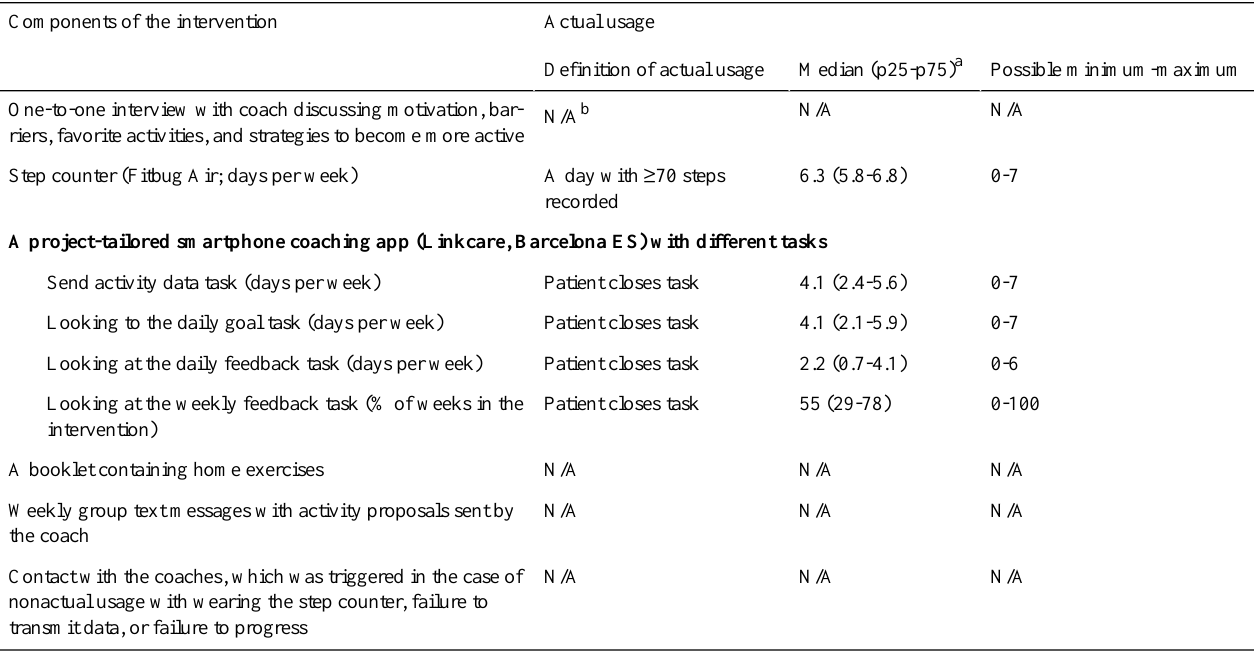
Table 2. Overview of the different components of the intervention. Definition of actual usage of the different components of the intervention of all completers (n=159 patients) and the minimum and maximum values one can achieve in terms of actual usage were reported when applicable. Actual usage and possible minimum-maximum are expressed as median (P25-P75) days per week for the step counter and the daily tasks on the app. Weekly feedback is expressed as median (P25-P75) percent of weeks in the intervention. Actual usageComponents of the intervention Possible minimum-maximumMedian (p25-p75) a Definition of actual